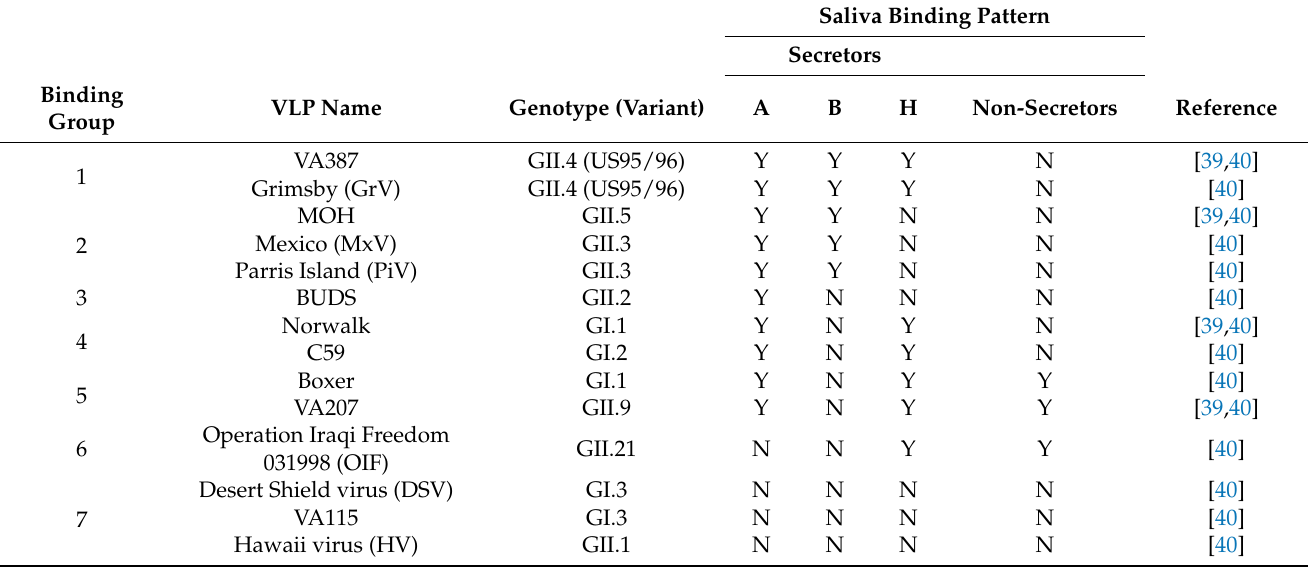
Table 2. Saliva binding patterns of HuNoV